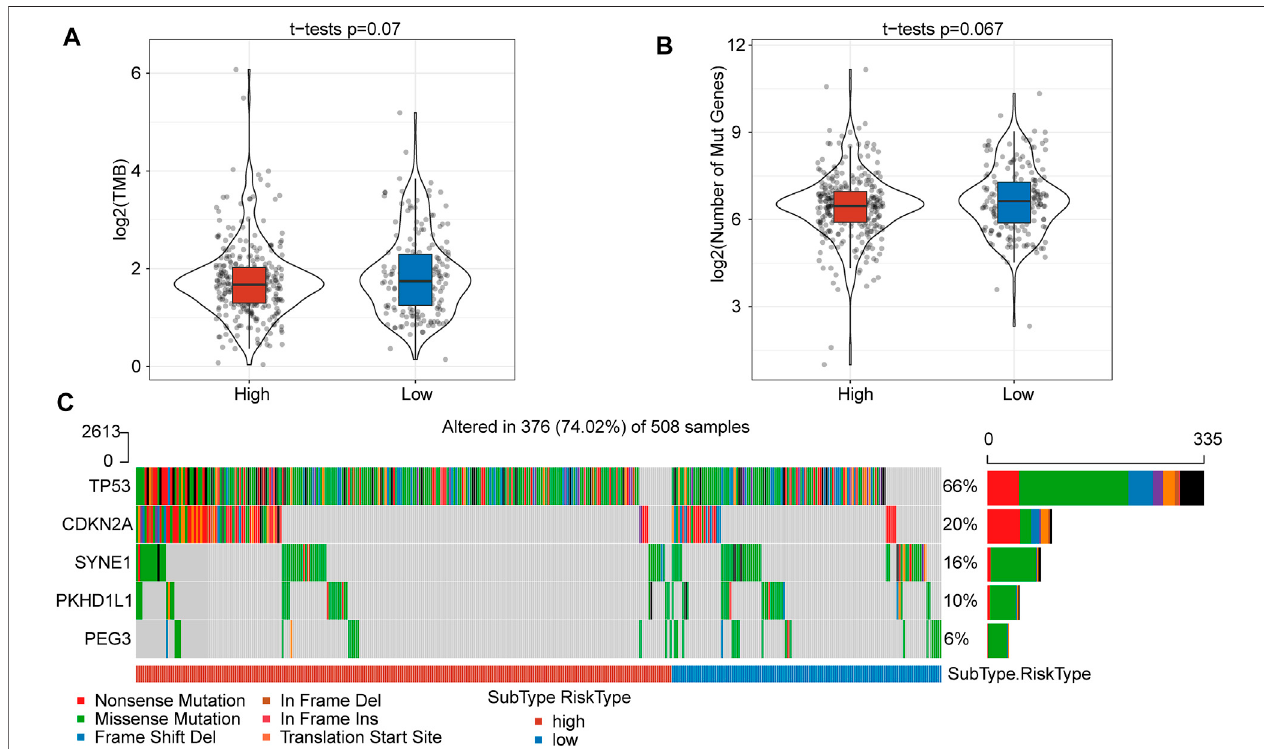
FIGURE 3 | The TMB and somatic mutation information between high- and low-risk score subgroups. (A) TMB score between the high- and low-risk subgroups showednosigni fi cantdifference. (B) Thenumberofmutatedgenesbetweenthehigh-andlow-risksubgroupswasnotsigni fi cantlydifferent. (C) Mutationcharacteristics of signi fi cantly mutated genes in the